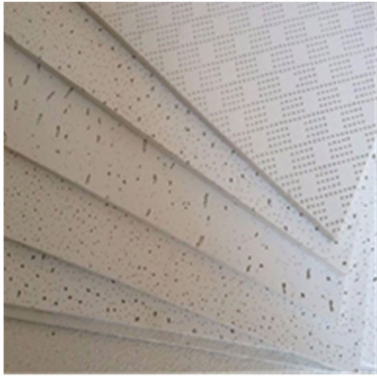
Figure 12. Mineral cotton fiber sound-absorbing